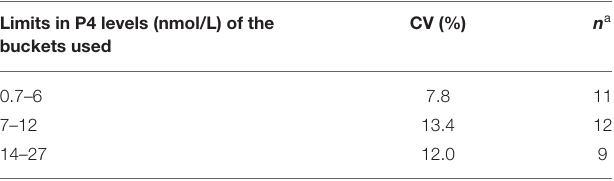
TABLE 2 | Coefficient of variation for the Catalyst Progesterone assay based on two assays per fresh serum sample, in quick succession and by the same